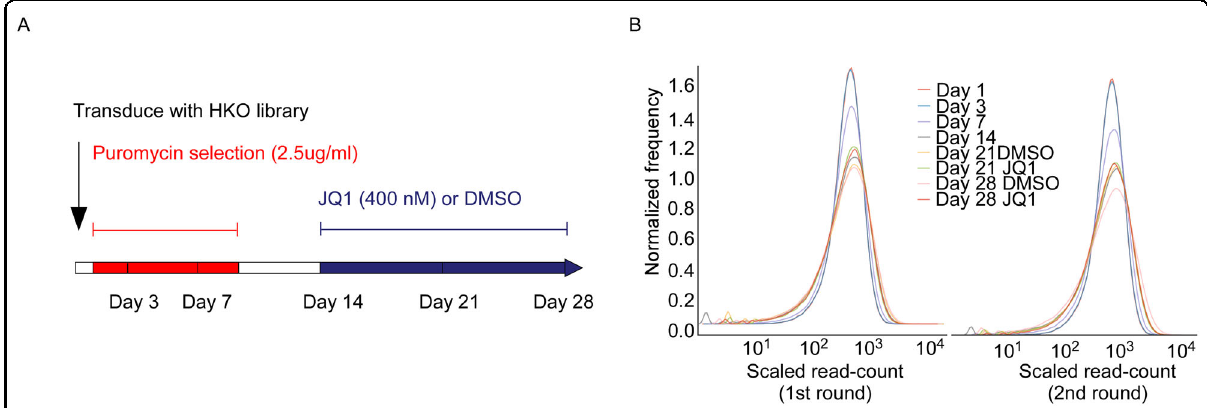
Fig. 2 Design of the CRISPR-Cas9 loss-of-function screen in the RC-K8 cell line. A Time points and drug treatments. The lentiCRISPR GeCKOv2 library was transduced at day zero. Puromycin selection for successful transduction was applied between day 1 and day 10. Drug treatments (JQ1 or DMSO vehicle) were applied after midpoint day 14. Cells were collected at six time points for sequencing, including day 1 as the baseline. B Distribution of read counts of guide sequences (rescaled and centred by the median of 1000). Compared to the baseline and the later time points, the distribution at day 7 is distinctive and has been used for detecting essential genes that caused rapid